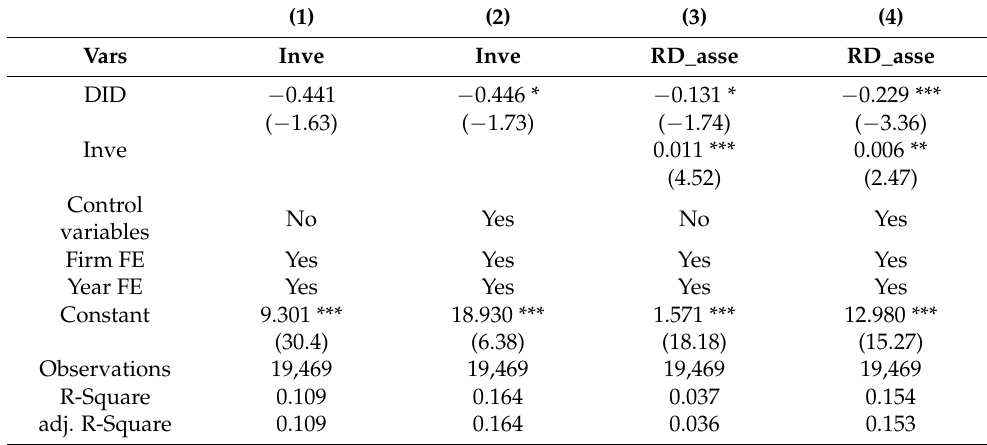
Table 8. Test of mediating effects of business confidence.